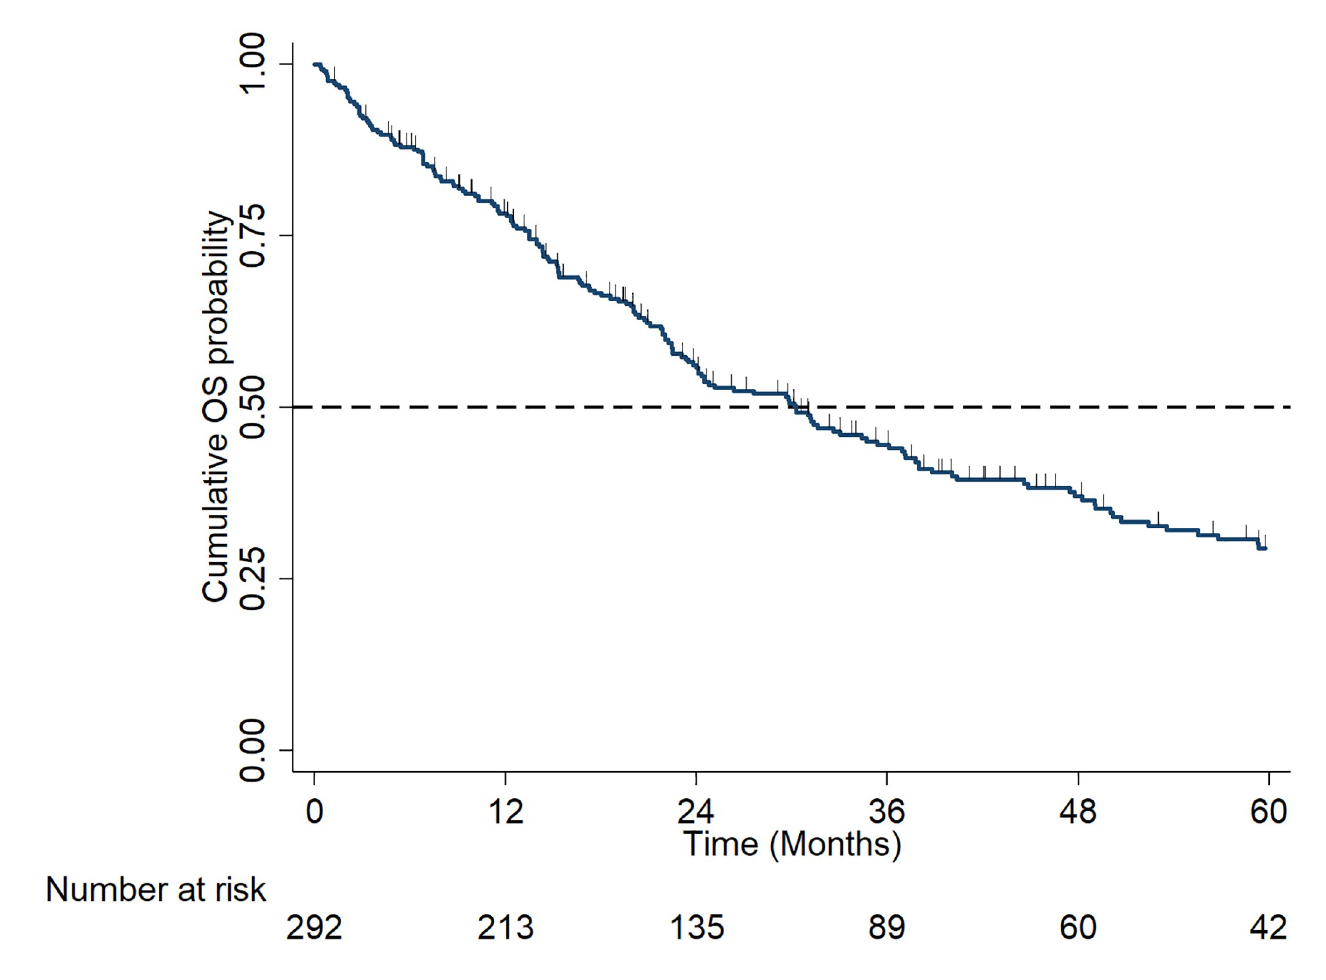
Fig 2. Kaplan Meier Curve of overall survival (OS) in the total cohort.